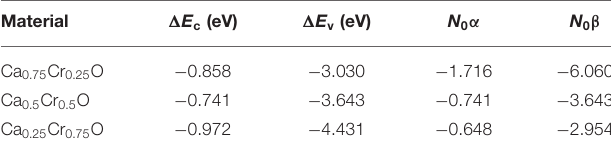
TABLE 5 | Computed conduction band-edge 1 E c (eV) and valence band-edge 1 E v (eV) spin-splittings, and sp-d exchange constants N 0 α and N 0 β for Ca 1-x Cr x O at concentrations x = 0.25, 0.5, and